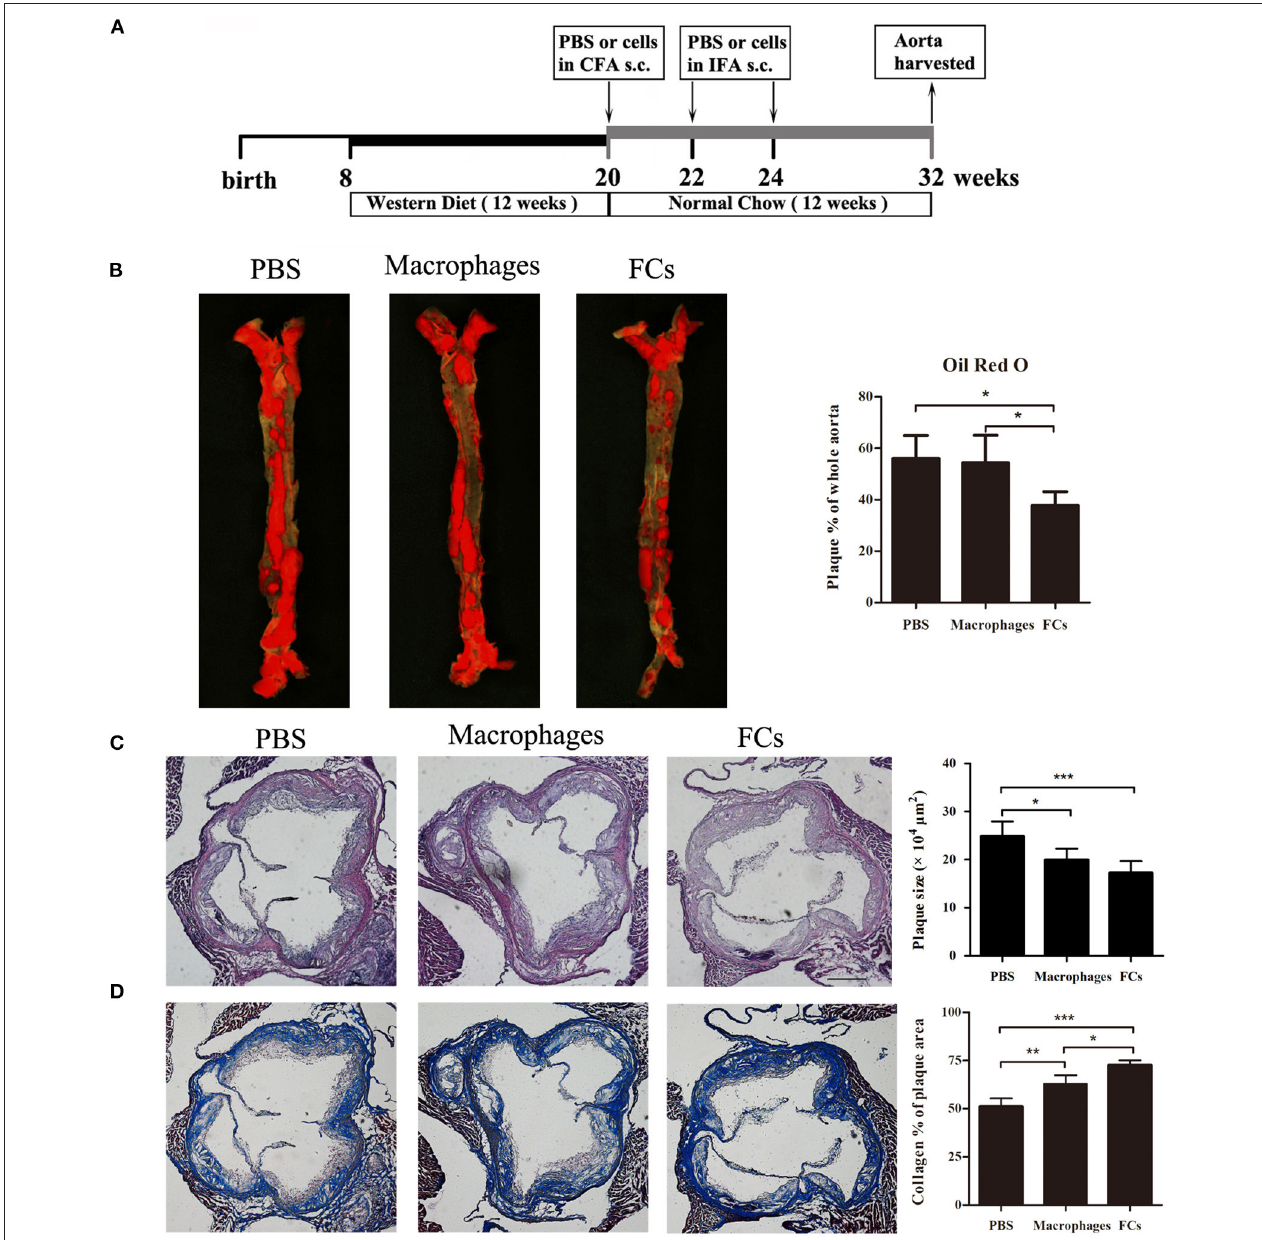
FIGURE 3 | FCs vaccination attenuates advanced lesion. (A) Experimental design of the therapeutic study. (B) En face lesion size of the whole aorta. (C) Plaque size in the three-valve area of the aortic root. (D) Collagen content in the aortic root. Scale bars, 200 µ m. All data are presented as mean ± SEM and are representative of all mice. n = 5–6 in each group; * p < 0.05; ** p < 0.01; *** p <